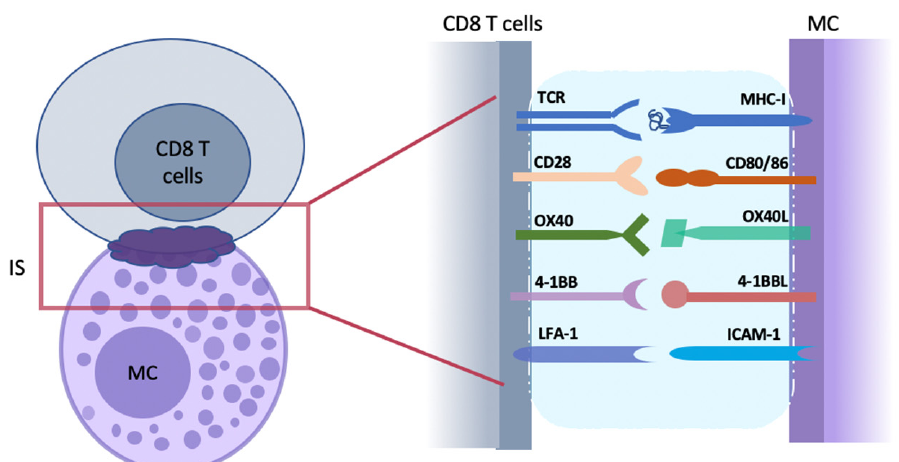
Figure 1. Direct cell–cell interactions between mast cells (MCs) and CD8 T cells. The tight apposition of antigen-presenting MC and antigen-recognizing CD8 T cell initiates the formation of an immu- nological synapse (IS; purple cloud) at the contact interface. IS is a platform with a nano-scale gap/distance formed for cell–cell communication and continent exchange. As the first step of T cell activation, the antigenic peptides bind with MHC-I and are presented to CD8 T cells that recognize them with TCR on the cell surface. Following with MHC-TCR interaction at IS, other molecules required for enhanced T-cell activation and structure modulation are recruited. Costimulatory mol- ecules pairs (such as CD28 and CD80/86, OX40 and OX40L, and 4-1BB and 4-1BBL) provide a second signal for the activation of naïve CD8 T cells. ICAM-1/IFA-1 are adhesion molecular pairs that are important for the formation and strengthening of IS structure. MC, mast cells; IS, immunological synapse.